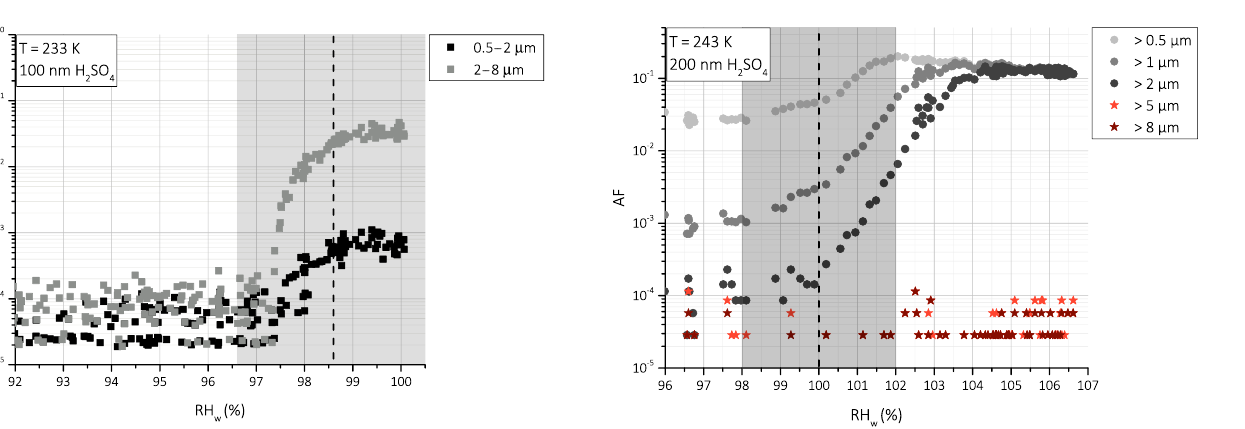
Figure 2. Homogeneous freezing curve of 100nm dry diameter H 2 SO 4 particles. AF as a function of RH w at 233K in the OPC size channels 0.5–2µm (dark grey) and 2–8µm (light grey). The dashed line (RH w = 98 . 6%) represents the expected RH w for ho- mogeneous freezing of dilute solution drops of an initial dry diam- eter of 100nm (Koop et al., 2000a), and the shaded region indicates the calculated range of RH w and uncertainty to which the particles in the aerosol layer in HINC are exposed.